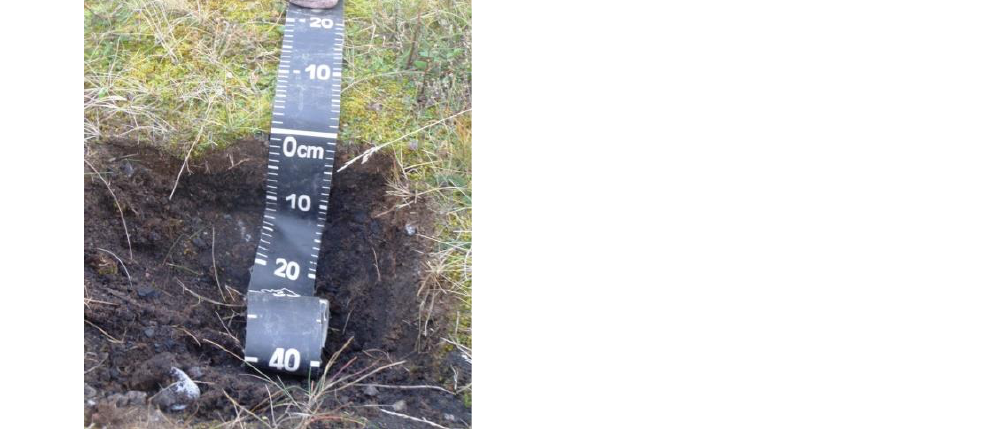
Figure 3. The photo of Petrozem (AY horizon) formed on rock material (Leptosol (Humic) — WRB).